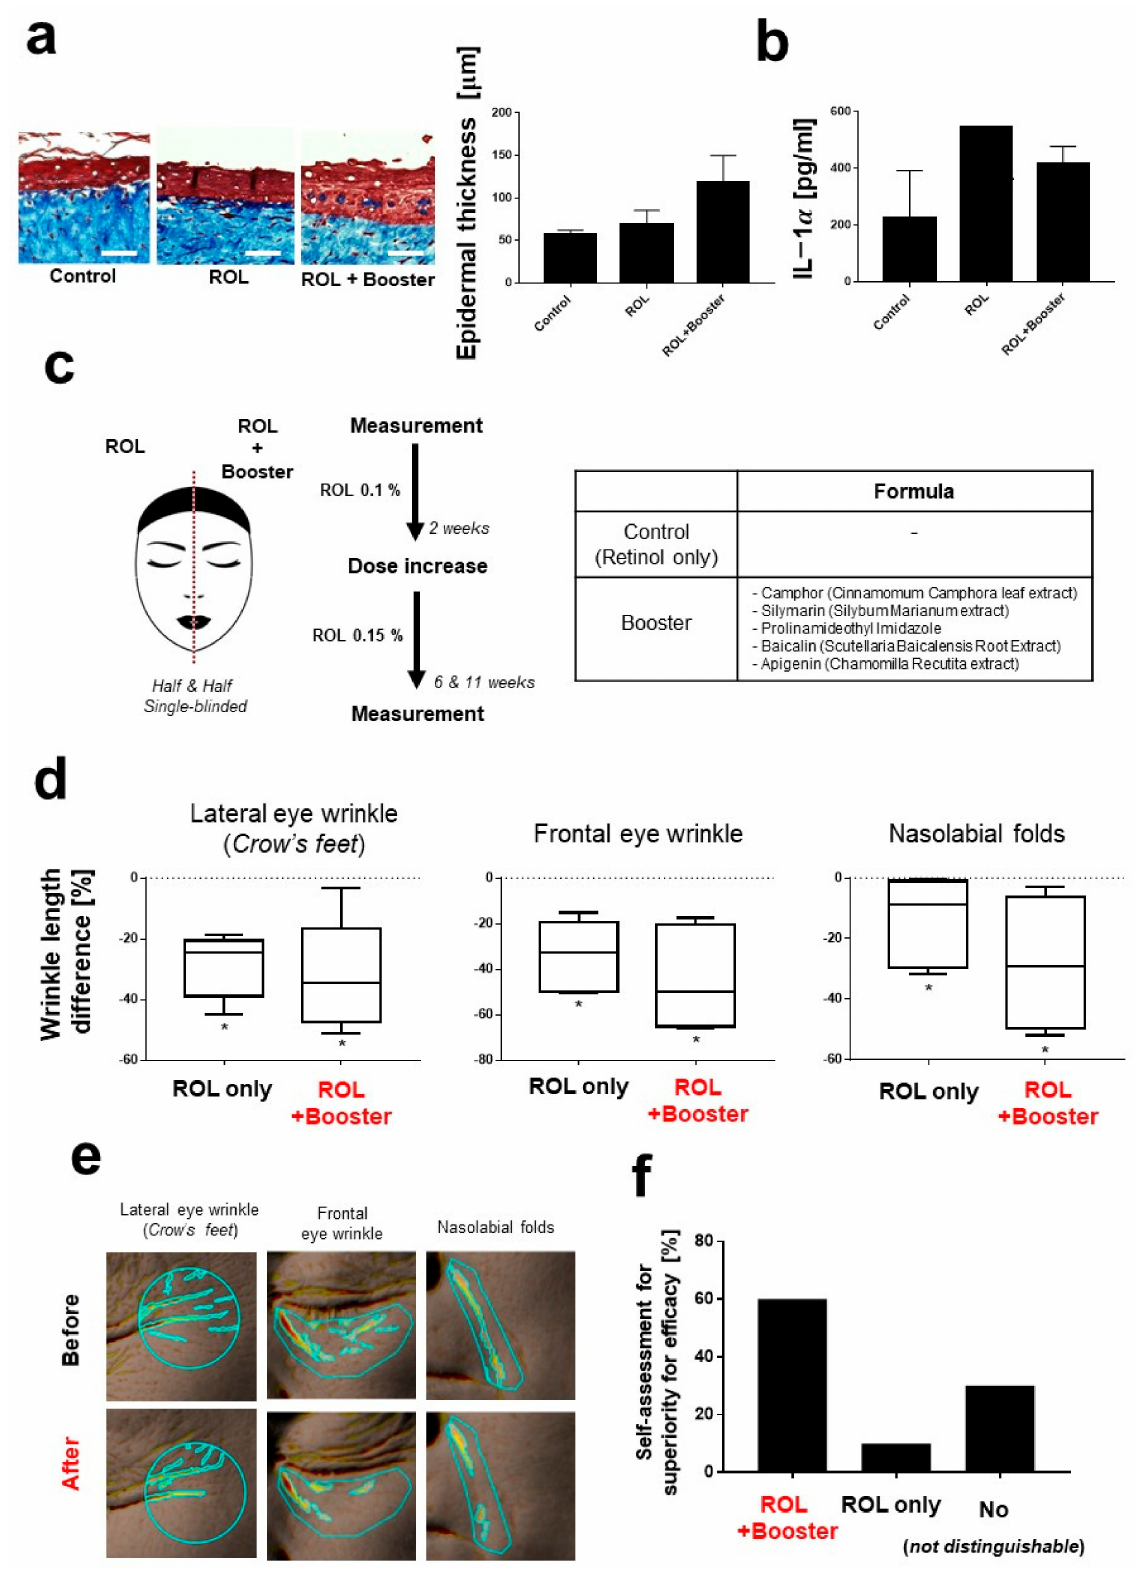
Figure 4. Efficacy of retinoids booster ex vivo and in vivo. ( a ) Epidermis thickening effects of retinol and retinol/booster. Scale bar, 50 µ m. ( b ) Expression of IL-1 α measured by ELISA. ( c ) Study design. Half & half, and single-blinded clinical test was performed. The table on the right shows the booster formulas for retinol. ( d , e ) Improvement in the appearance of wrinkles by retinol and